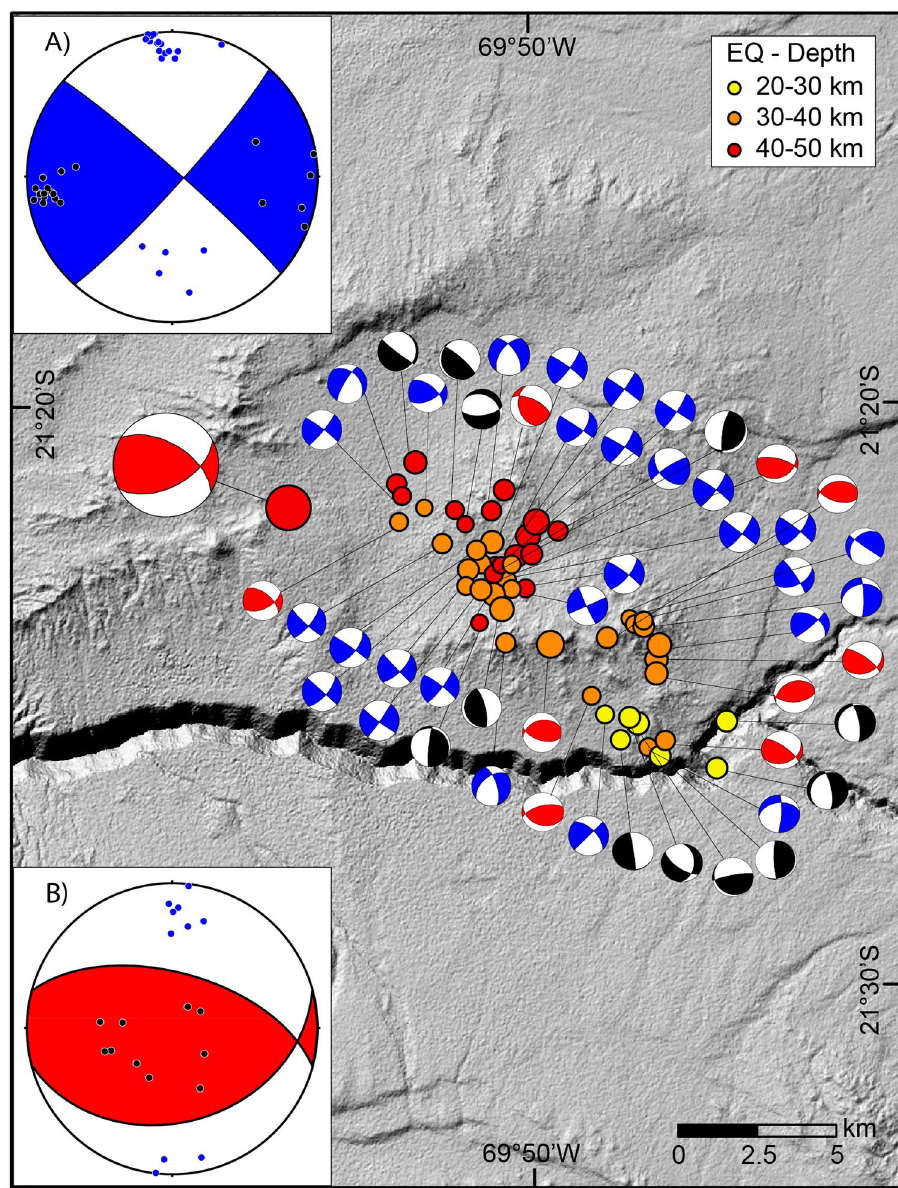
Figure 4. Summary of focal mechanisms of the M w 6.3 main event and aftershocks based on FOCMEC programme 27 . (A) Composite moment tensor solution for strike-slip aftershocks showing the compressional axes (blue circles) and tensional axes (black circles), (B) composite moment tensor solution for reverse aftershocks. Composite moment tensor solutions are based on FaultKin software (http:// www. geo. corne ll. edu/ geolo gy/ facul ty/ RWA/ progr ams/ fault kin. html). Black featured moment tensor solutions represent tensional aftershocks. The background hillshade map was generated in ArcGIS 10.8.2 (https:// www. esri. cl/ es- cl/ inicio) based on the 12.5-m DEM provided by open-access ALOS PALSAR data (https:// search. asf. alaska.